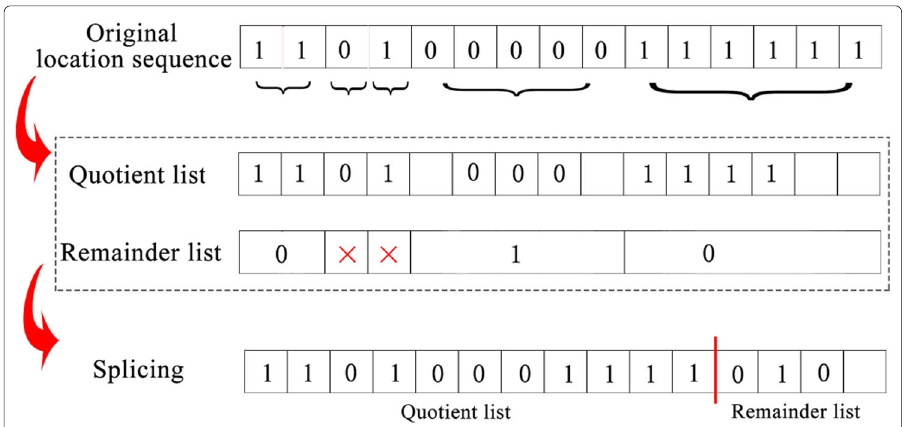
Fig. 4 An example for proposed halving compression algorithm with T 1 = 2, T 0 = 2. The original location sequence 110100000111111, quotient list 11010001111, and remainder list 010. The compressed location sequence 11010001111010 can be directly obtained by combining remainder list and quotient